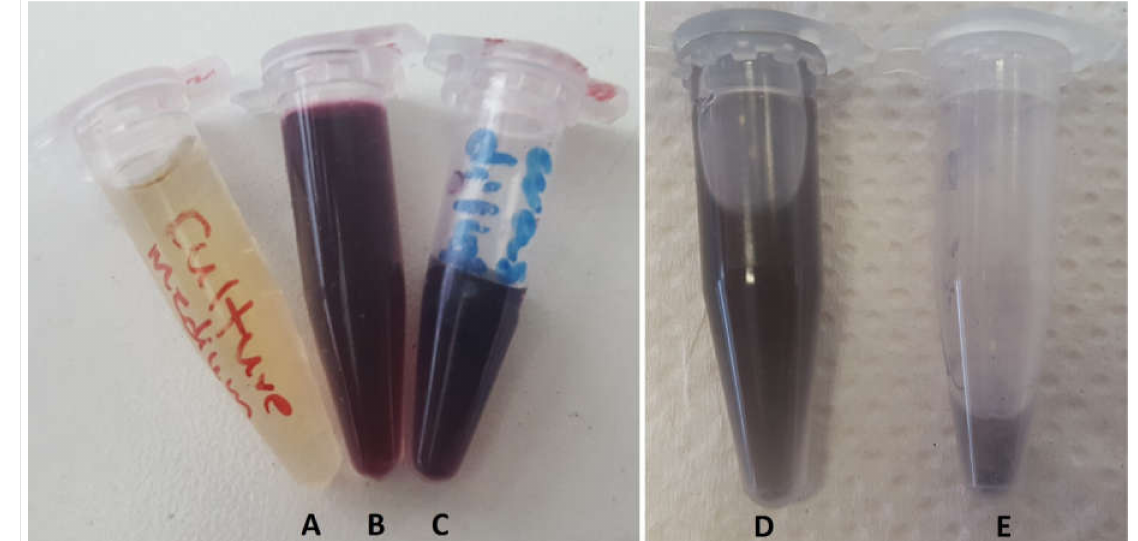
Figure 3. Samples with different pH levels before and after the washing process exhibited different behavior: ( A ) control (mycelium-free supernatant); ( B ) gold nanoparticles prepared at pH 10 before washing; ( C ) gold nanoparticles prepared at pH 10 after washing; ( D ) gold nanoparticles prepared at pH 4 before washing; ( E ) gold nanoparticles prepared at pH 4 after